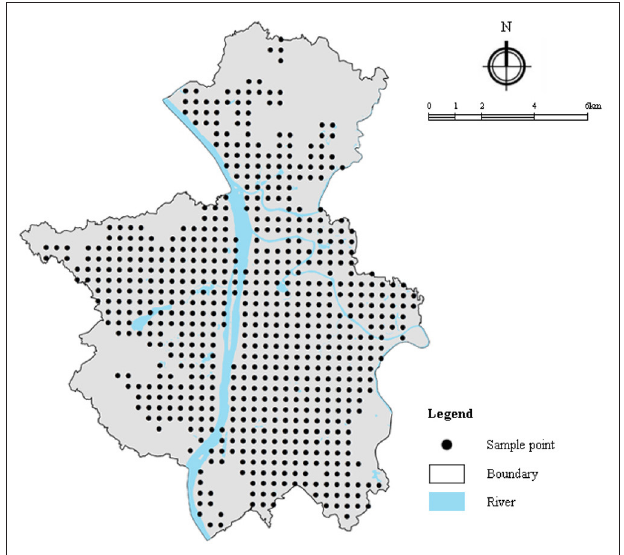
FIGURE 3 | Sample points in the case study area.